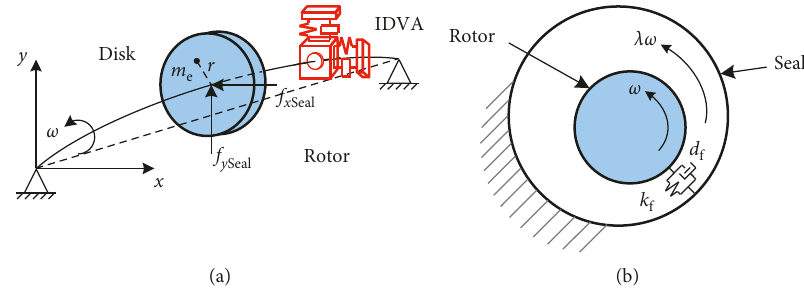
Figure 1: The model of the rotor/seal system with the IDVA.